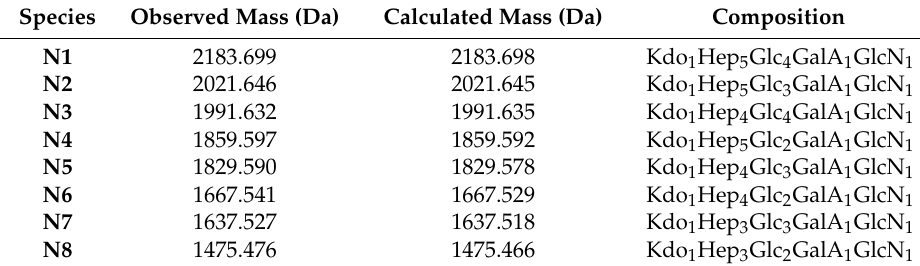
Table 3. Composition of the main species observed in the charge deconvoluted ESI FT-ICR mass spectrum of supernatant of the acetic acid hydrolysed LPS fraction (L-OS AcOH ) isolated from E. amylowora waa L.